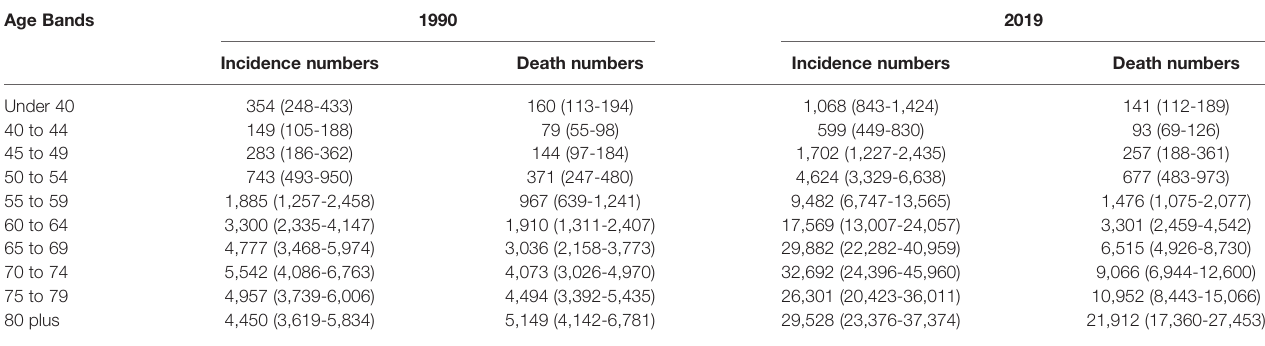
TABLE 3 | The incidence and death numbers for Prostate Cancer by age bands a in 1990 and